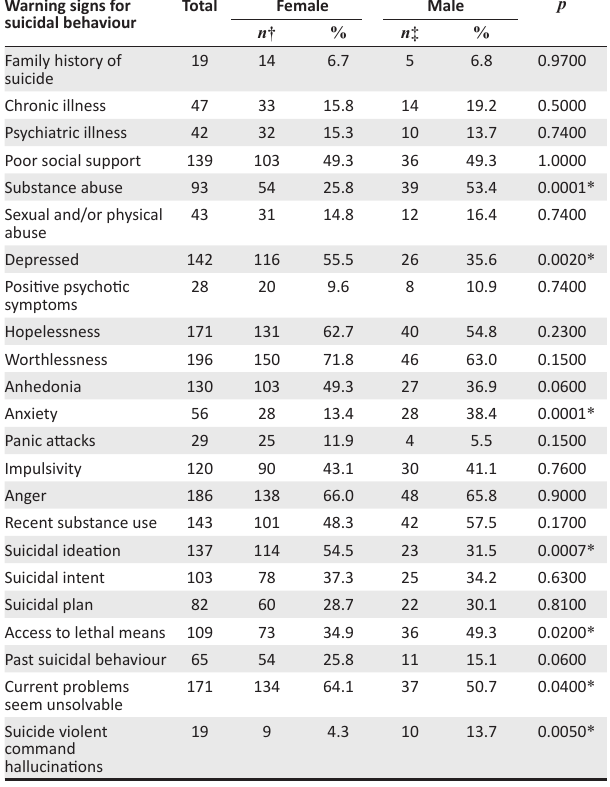
TABLE 2: Gender differences in the development of suicidal behaviour.